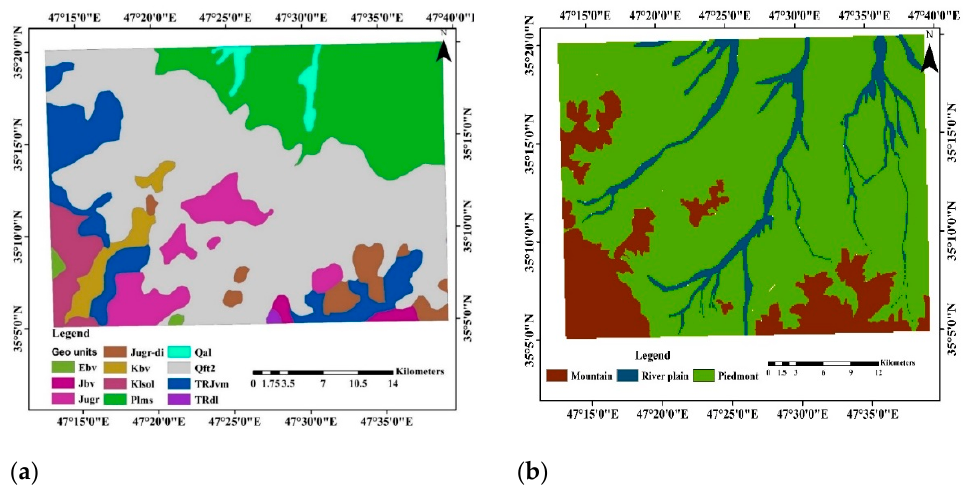
Figure 2. Illustration of the distribution of geologic ( a ) and geomorphic ( b ) units in the study area, west of Iran.